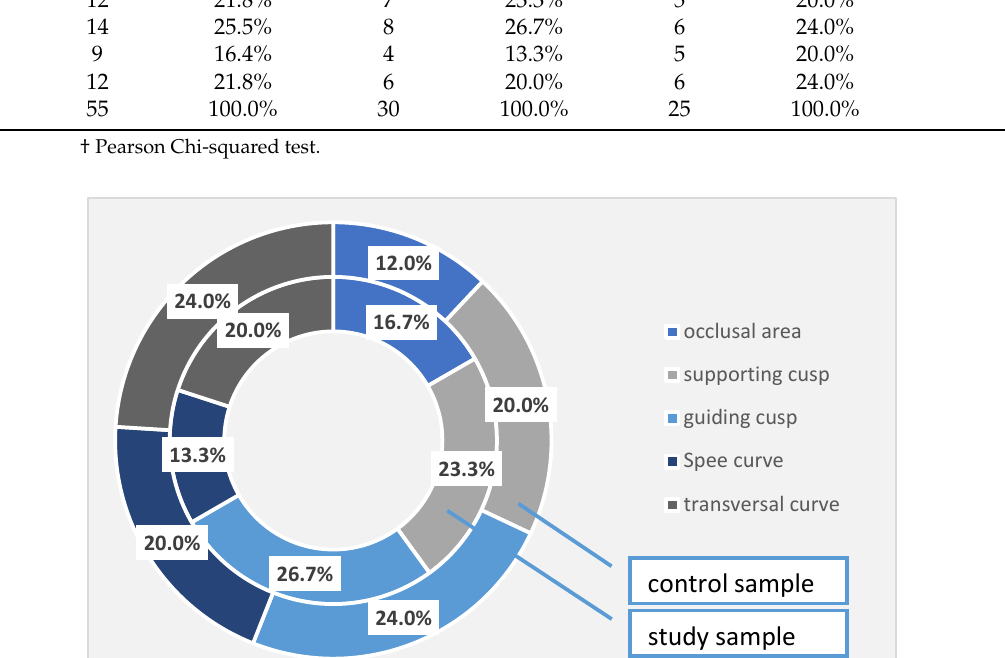
Figure 2. Occlusal changes identified at the investigated patients (the total sample).